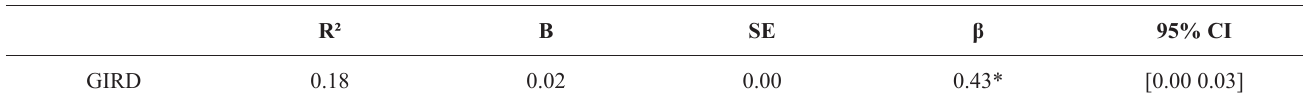
Table 3 - Regression analysis (n =